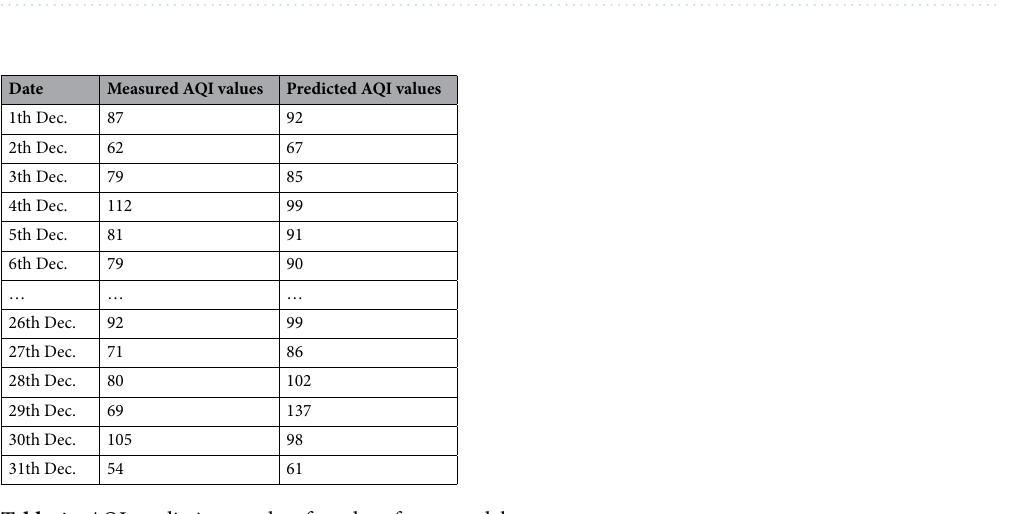
Table 4. AQI prediction results of random forest